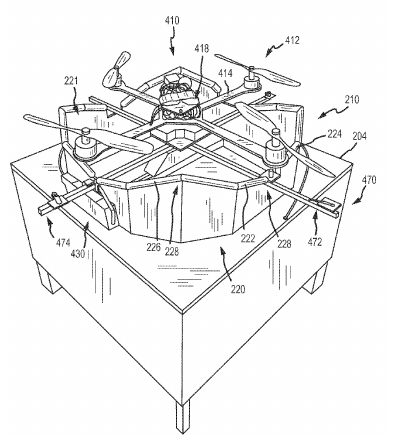
Figure 36. System for the autonomous docking and charging of an unmanned aerial vehicle with a closed contour for positioning [91] by ETHZ and Disney Enterprises Inc. 222, 224, and 226, receiving surfaces (inclined); 228, tops of receiving surfaces; 410, UAV; 414, rotor supports (beams); 474, levers (horizontal